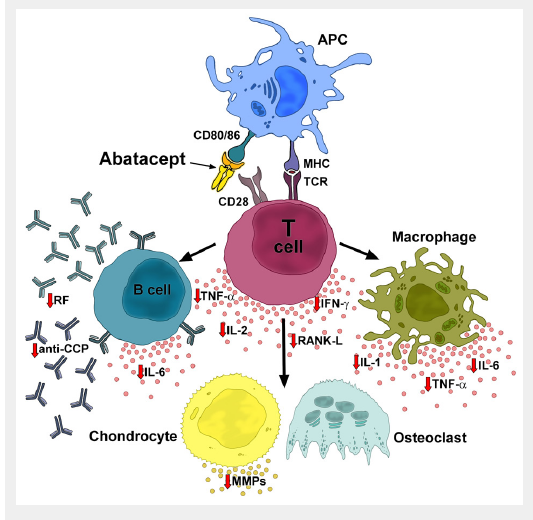
Mode of action of abatacept. By binding to CD80/86, abatacept blocks the interaction of CD80/86 and CD28 on the APC and T cell, respectively. The co-stimulatory pathway leading to T-cell activation is inhibited and processes in the inflammatory cascade are downregulated, resulting in normalized levels of cytokines and autoantibodies, and inhibition of osteoclast activity. APC: antigen presenting cell (e.g., macrophages, dendritic cells, B cells); MHC: major histocompatibility complex; TCR: T-cell receptor; RF: rheumatoid factor; TNF: tumour necrosis factor; IFN: interferon; IL: interleukin; anti-CCP: anti-cyclic citrullinated peptide; RANK: receptor activator of NF-κB; MMPs: matrix